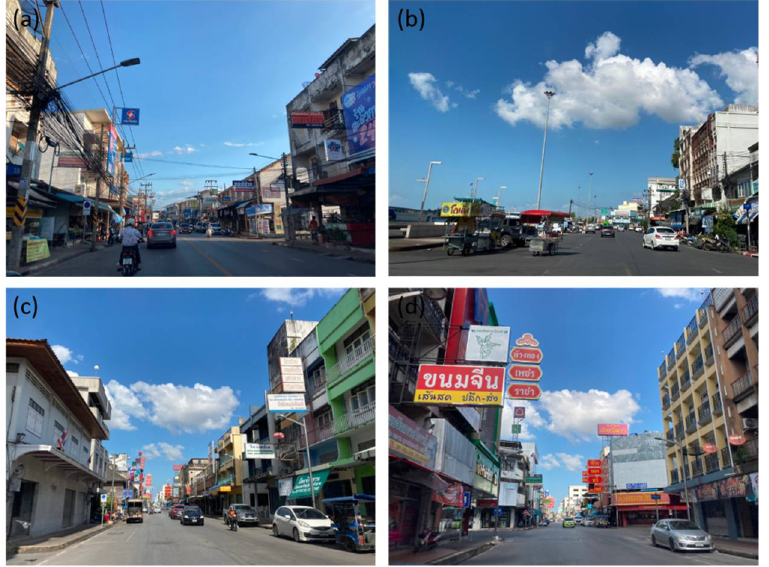
Figure 2. The scenes of the inner zone of Surat Thani city ( a , b ); the old central district close to Ta Pi River and the new business district along the Talad Mai Road, a major city road ( c , d ).